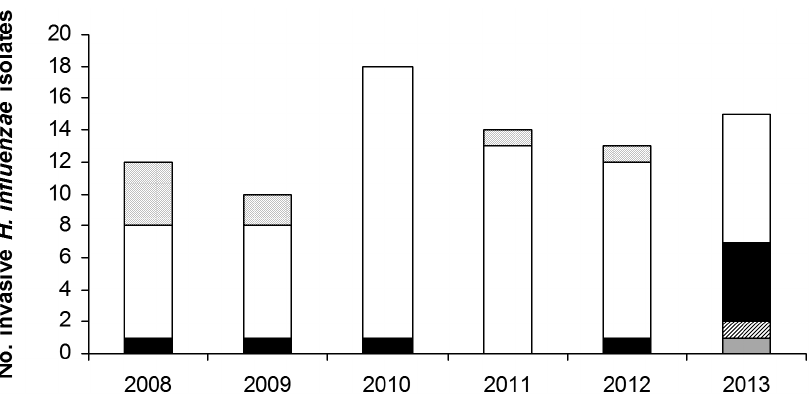
Figure 1. Distribution of 82 invasive H.influenzae isolated from adult patients (2008–2013). White bar: nontypeable H. influenzae . Black bar: H. influenzae serotype f. Dotted bar: no available isolated for serotyping. Grey bar: H. influenzae serotype b. Lined bar: H. influenzae serotype